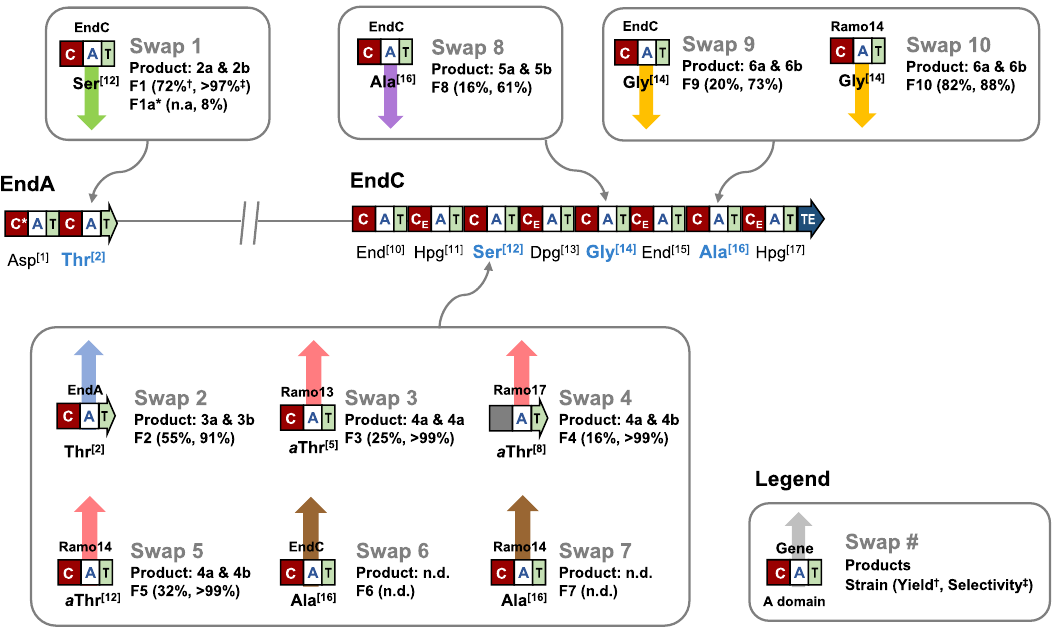
Fig. 4 Overview of the primary (Swap 1 – 10) subdomain swap mutants generated in this study. Most of the subdomain swaps were designed for endC , the largest NRPS, containing multiple repeating sequences, which presents a signi fi cant challenge for engineering conventional homologous recombination methodologies. *Swap via gene complementation, † Relative titre of engineered variants ( 2 – 6 ) compared titres of 1 produced by wild type, ‡ selectivity for new products ( 2 – 6 ) over parent enduracidin ( 1 ) in engineered NRPS. Coloured arrows are used to indicate different amino acid swaps: green (Thr [2] to Ser), blue (Ser [12] to Thr), pink (Ser [12] to a Thr), brown (Ser [12] to Ala), purple (Gly [14] to Ala) and yellow (Ala [16] to Gly). Source data for yield and selectivity are provided with this